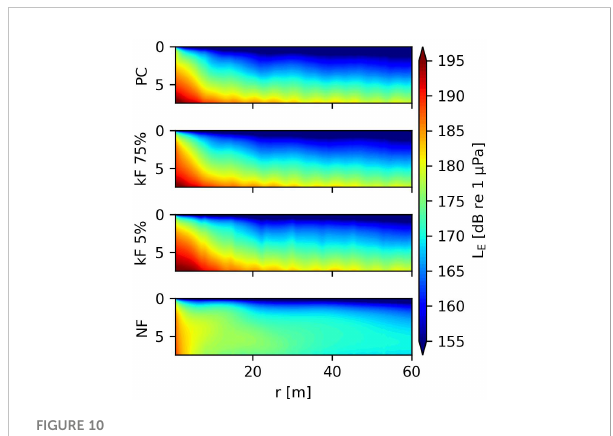
FIGURE 10 Sound exposure levels in dB versus depth and height in the fl uid throughout 1 second